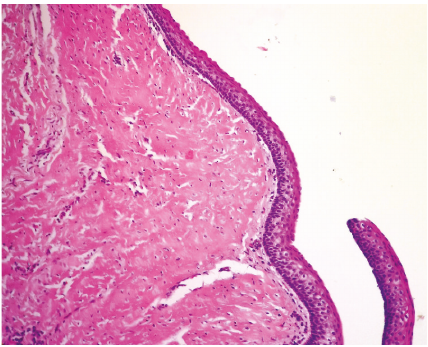
Figure 5: The cystic fi brous wall is coated with a thin strati fi ed epithelium with an accumulated parakeratotic layer on the surface. The basal layer of the cells shows characteristic palisadisation of the hyperchromatic nuclei.